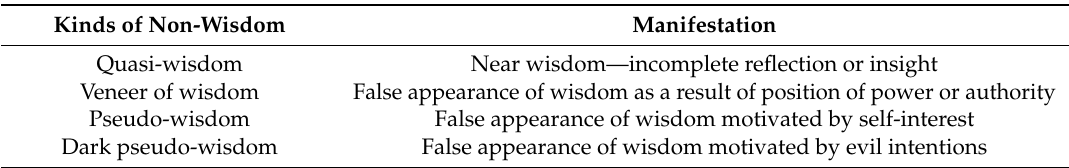
Table 2. Kinds of